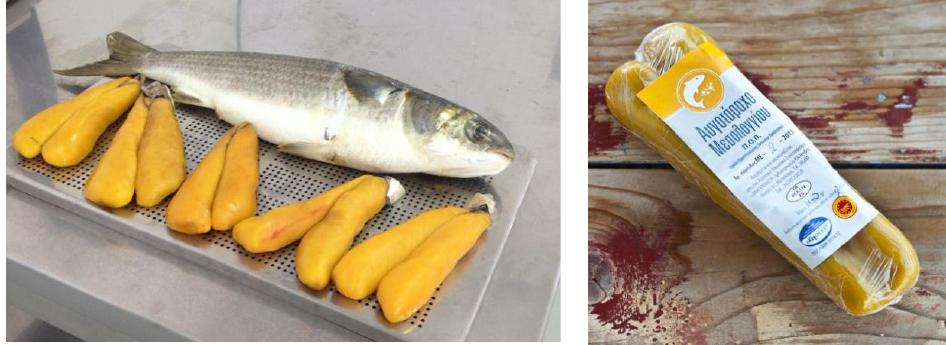
Figure 1. Greek Bottarga from Messolongi (Fish–Roe) Registered “Avgotaracho Messolongiou” PDO.